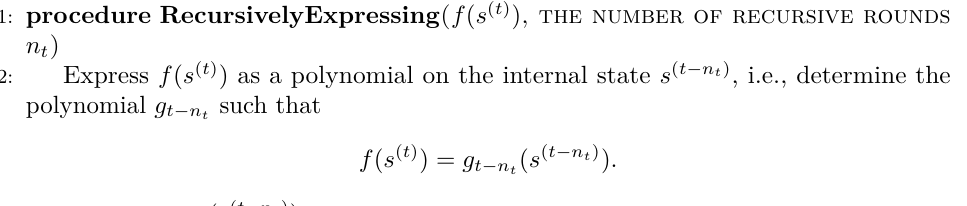
scribing the final division property after t rounds